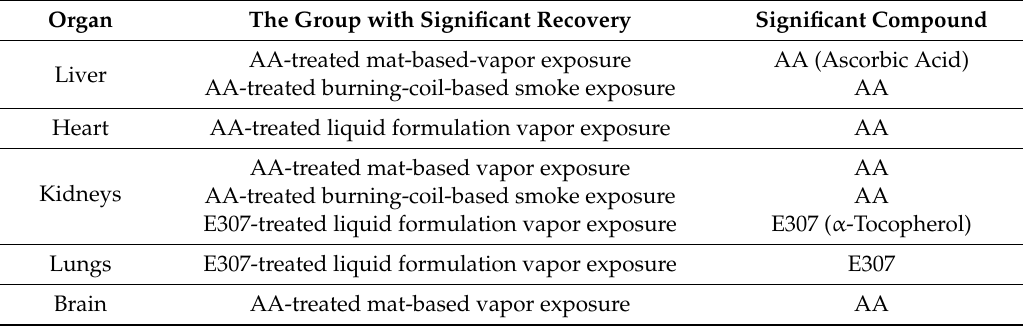
Table 1. Predominant e ff ects of AA and E307 on the tissues of experimental